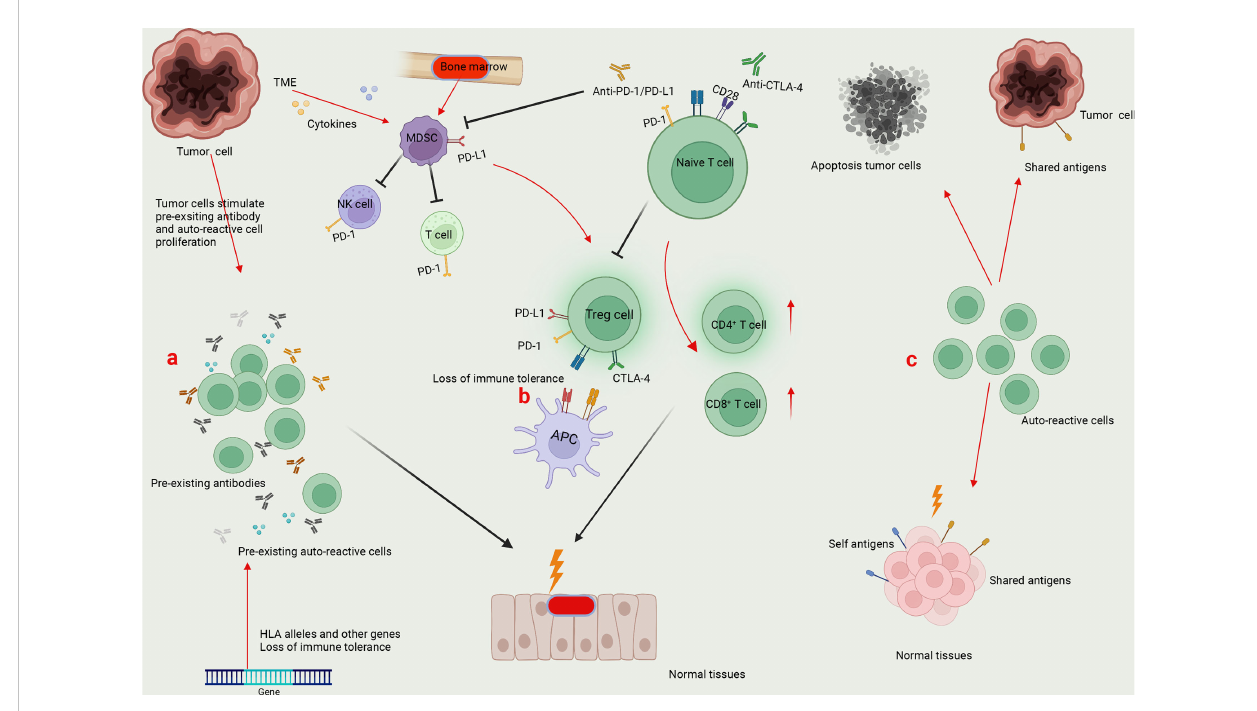
FIGURE 1 Mechanisms underlying irAEs. (A) Speci fi c HLA alleles and other genes result in the generation of pre-existing auto-reactive cells and antibodies in cancer patients. The enhanced auto-reactive cells by checkpoint inhibitors further promotes the production of autoantibodies, leading to the attack of normal tissues. (B) Tumor microenvironment (TME) favors the generation of myeloid-derived suppressor cells (MDSCs), which directly suppress antitumor immunity by expressing PD-L1 and indirectly induce Treg differentiation to inhibit T-cell function. On one hand, the application of ICIs to block PD-1/PD-L1 and CTLA-4-mediated immune suppression may affect the function of MDSCs and Tregs, leading to the loss of immune tolerance. On the other hand, by promoting the effector function of CD4 + T and CD8 + T cells, ICI treatment enhances the potential immune responses against normal tissues. (C) Tumor cells can express shared antigens with normal tissues. Meanwhile, tumor cell death releases self and tumor antigens. The auto-reactive T cells can recognize shared or self antigens, leading to the collapse of immune tolerance and normal tissue